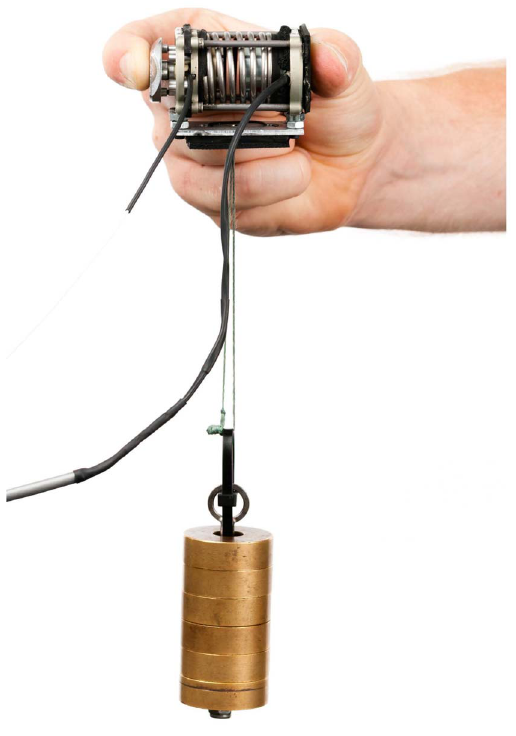
Figure 1. Stiffness change due to cocontraction. Increasing the cocontraction of the corresponding muscles increases the offset in the stiffness/force relationship.